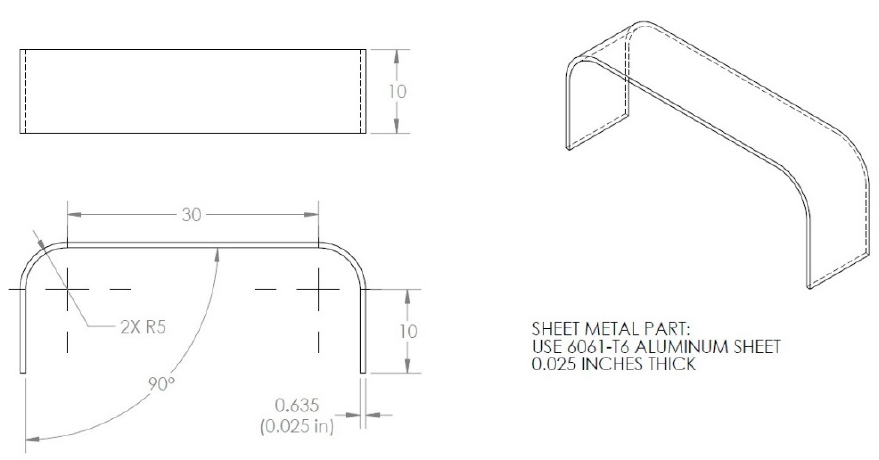
Figure 4. Aluminum U ‐ shaped sheet metal (dimensions in mm).